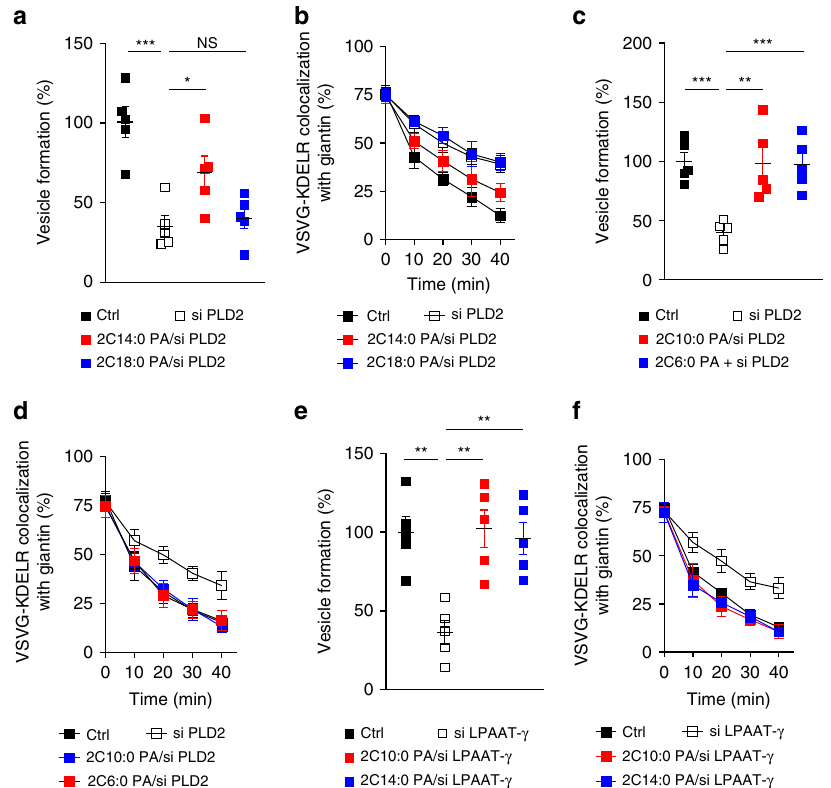
Fig. 2 Phosphatidic acid (PA) in late Coat Protein I (COPI) vesicle fi ssion. Quantitative data are shown as mean ± s.e.m. Signi fi cance was tested using the two-tailed Student ’ s t test, * P < 0.05, ** P < 0.01, *** P < 0.0001, NS P > 0.05. a Golgi membrane with reduced phospholipase D type 2 (PLD2) level was